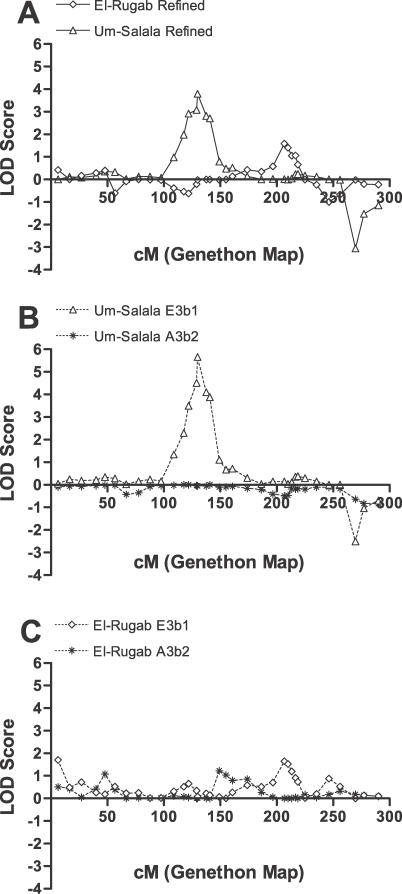
Genome Scan Data for Chromosome 1 for Multicase Families of Visceral Leishmaniasis from Sudan(A) refined mapping data by village; (B) refined map stratified by Y chromosome haplotype for Um-Salala; (C) refined map stratified by Y chromosome haplotype for El-Rugab. Multipoint LOD scores (plotted as sign(dhat)•LOD[36]) are shown on the vertical axis and the distance in cM (Genethon Map) from the p terminus on the horizontal axis. To ensure that allele-sharing LOD scores were not inflated or biased by particular individuals or families, we recalculated LOD scores randomly, dropping one pedigree at each analysis. The mean ± SD peak LOD score at 1p22 was 5.17 ± 0.83 (range 3.97–7.08), indicating most E3b1 pedigrees contribute to this linkage peak. Information contents over the region of linkage at 1p22 (114–135 cM) were (mean ± SD) 0.71±0.03 (range 0.72–0.82) for Um-Salala refined map in (A), 0.74 ± 0.05 (range 0.69–0.84) for Um-Salala E3b1 families in (B), and 0.59 ± 0.04 (range 0.56–0.65) for El-Rugab E3b1 families. Information contents over the region of linkage at 1q31 (207–219 cM) were 0.56 ± 0.05 (range 0.50–0.63) for El-Rugab refined map in (A), and 0.61 ± 0.04 (range 0.56–0.66) for Um-Salala E3b1 families in (B), and 0.56 ± 0.07 (range 0.47–0.62) for El-Rugab E3b1 families in (C).